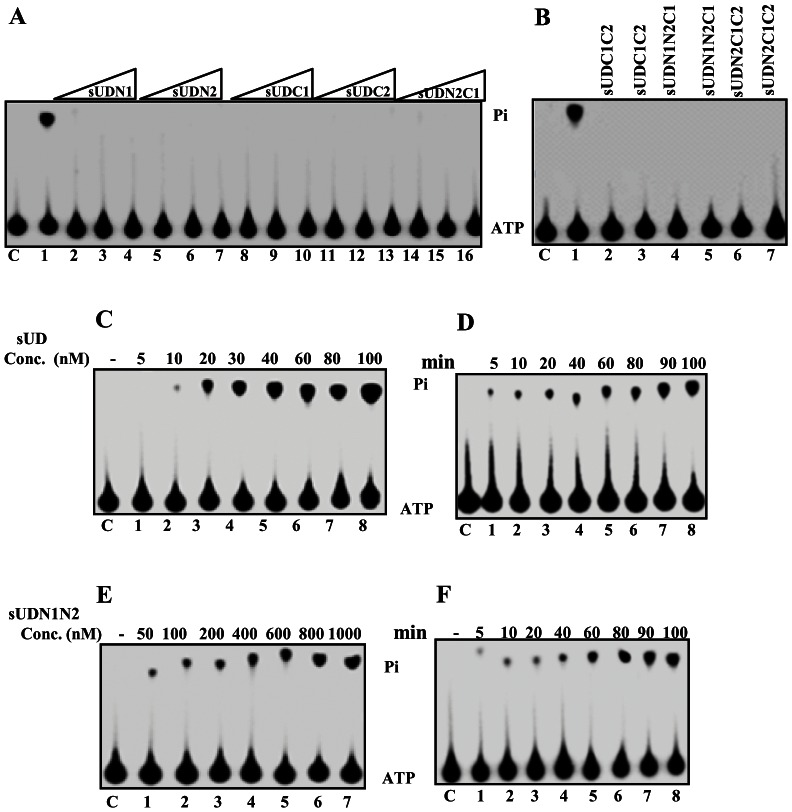
Analysis of ATPase activity.A. Lane 1, sUD, lanes 2–4, increasing concentration of sUDN1, lanes 5–7, increasing concentration of sUDN2, lanes 8–10, increasing concentration of sUDC1, lanes 11–13, increasing concentration of sUDC2, and lanes 14–16, increasing concentration of sUDN2C1. B. Lane 1 contains sUD, lanes 2–3, increasing concentration of sUDC1C2, lanes 4–5, increasing concentration of sUDN1N2C1, lanes 6–7, increasing concentration of sUDN1N2C2. C. Concentration dependent ATPase activity of sUD, Lanes 1–8 are increasing concentration of sUD and concentration are labelled at top of the autoradiogram. D. Time dependence of ATPase activity of sUD. The time of incubation in minutes is mentioned at the top of the autoradiogram and C is the control reaction without enzyme. E. Concentration dependent ATPase activity of sUDN1N2, Lanes 1–7 are increasing concentration of sUDN1N2 and concentration are labelled at top of the autoradiogram. F. Time dependence of ATPase activity of sUDN1N2. The time of incubation in minutes is mentioned at the top of the autoradiogram. C in panels A–F is the control reaction without enzyme. see also Figure S4.